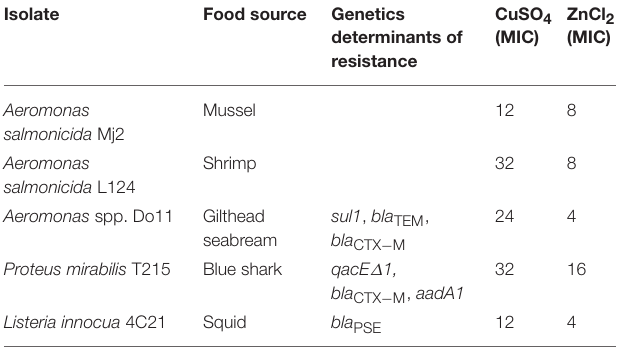
TABLE 3 | Characterization of selected